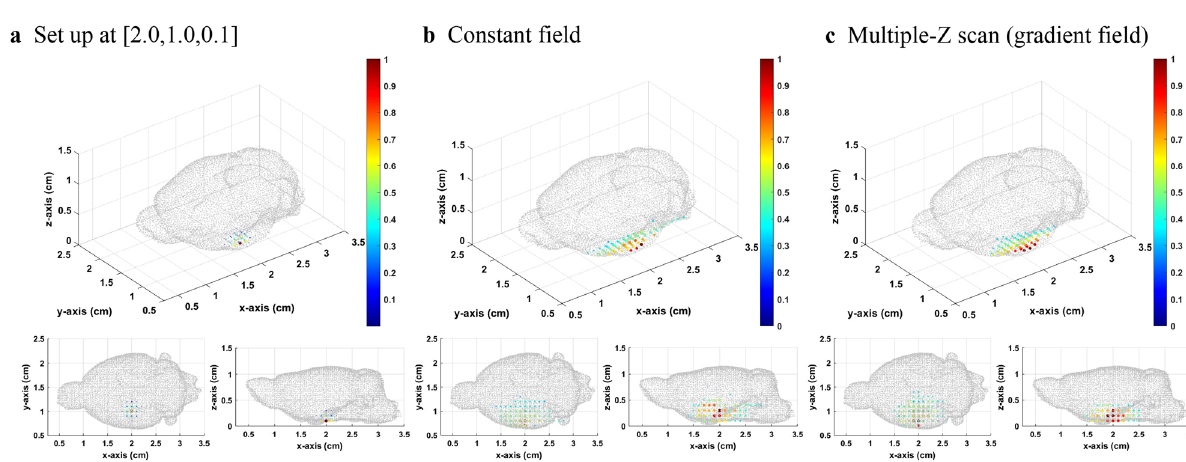
Figure 7. ( a ) The original source distribution center at [2.0,1.0,0.1], ( b ) inverse distribution calculated from the lead field matrix of MPI system with the constant field, and c inverse distribution result from the multiple Z scan (gradient field) with thresholds equal to